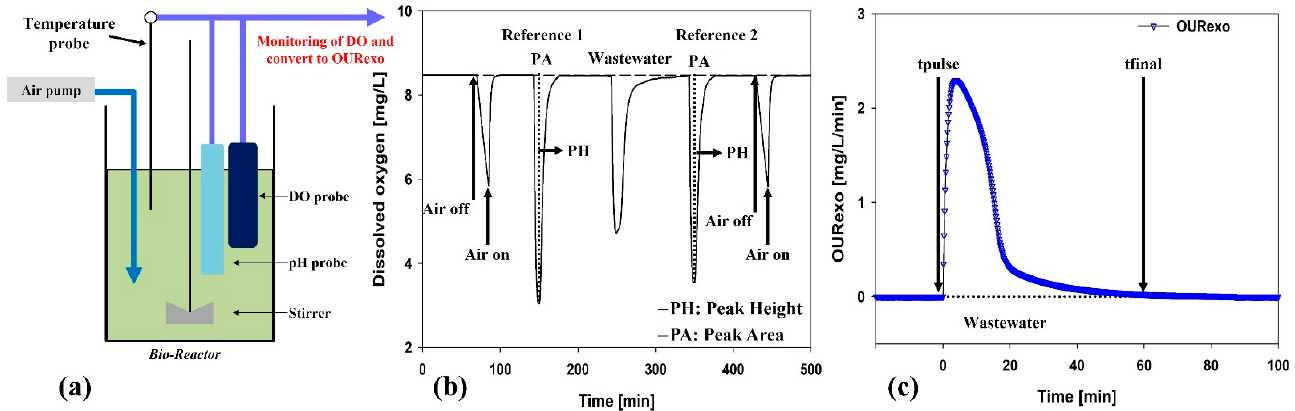
Figure 2. Schematic diagram of respirometer experiments: ( a ) respirometer equipment; ( b ) DO profiles for toxicity, short-term BOD, and kinetics tests; ( c ) determination of short-term BOD or kinetics analysis using 𝑂𝑈𝑅 (cid:3032)(cid:3051)(cid:3042) profiles.